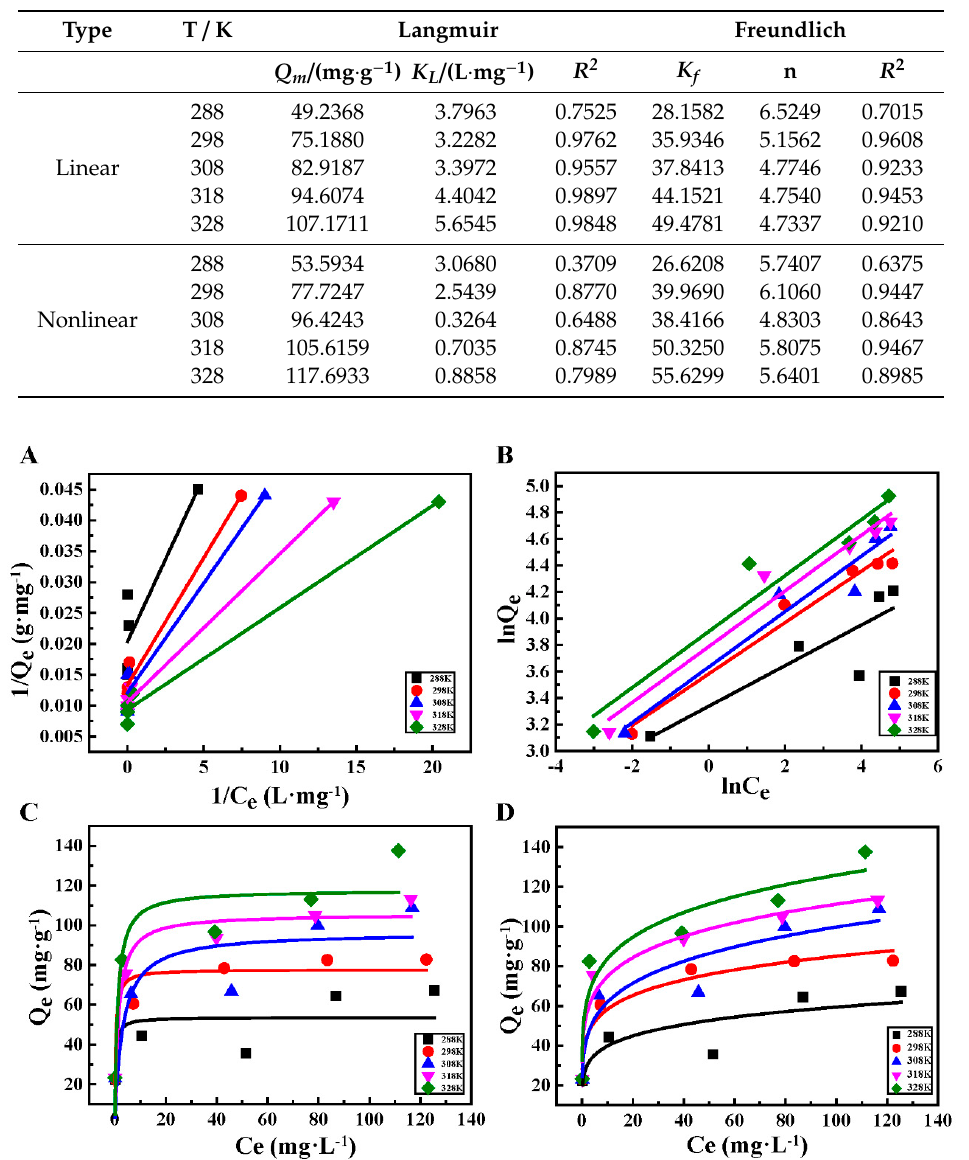
Figure 4. ( a , c ) Linear and nonlinear fit of the Langmuir model; ( b , d ) linear and nonlinear fits of the Figure 4. ( A , C ) Linear and nonlinear fit of the Langmuir model; ( B , D ) linear and nonlinear fits of the Freundlich model. Freundlich Table 2. Langmuir and Freundlich model parameters of HHTB adsorption Pb 2+.